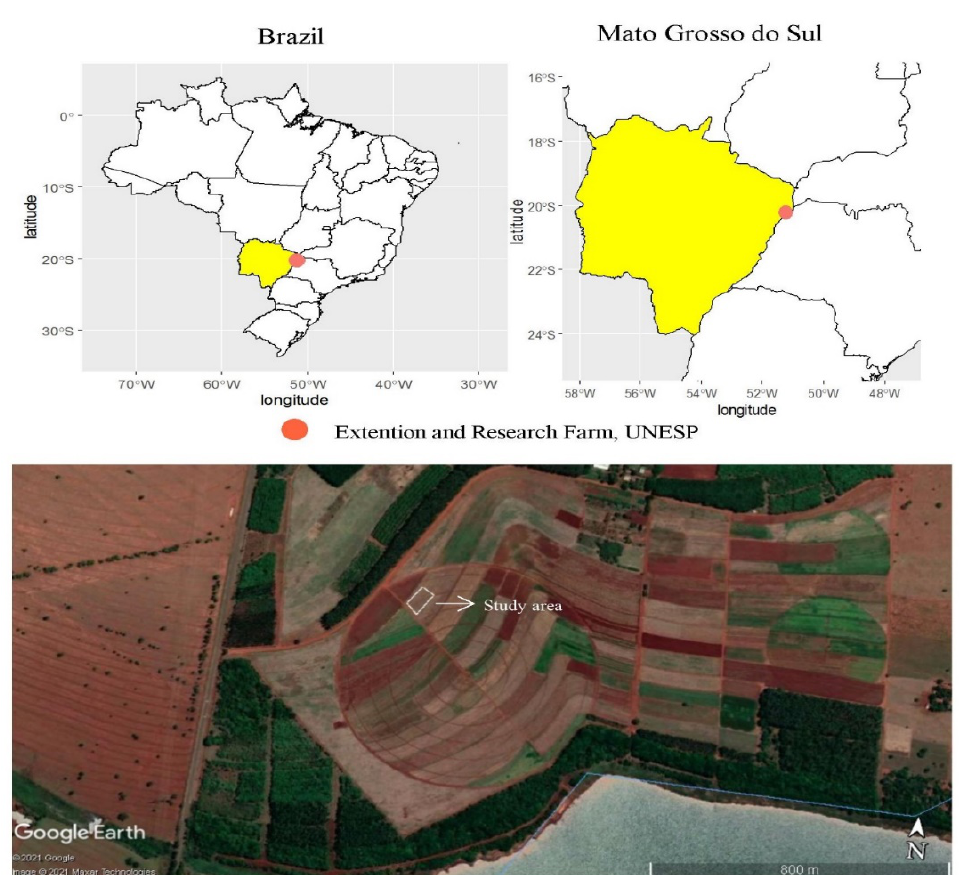
Figure 4. Location of the experimental area at Extension and Research Farm, UNESP—Ilha Solteira Campus, at Selvíria, state of Mato Grosso do Sul, Brazil (20°22′ S, 51°22′ W, altitude of 335 m) in